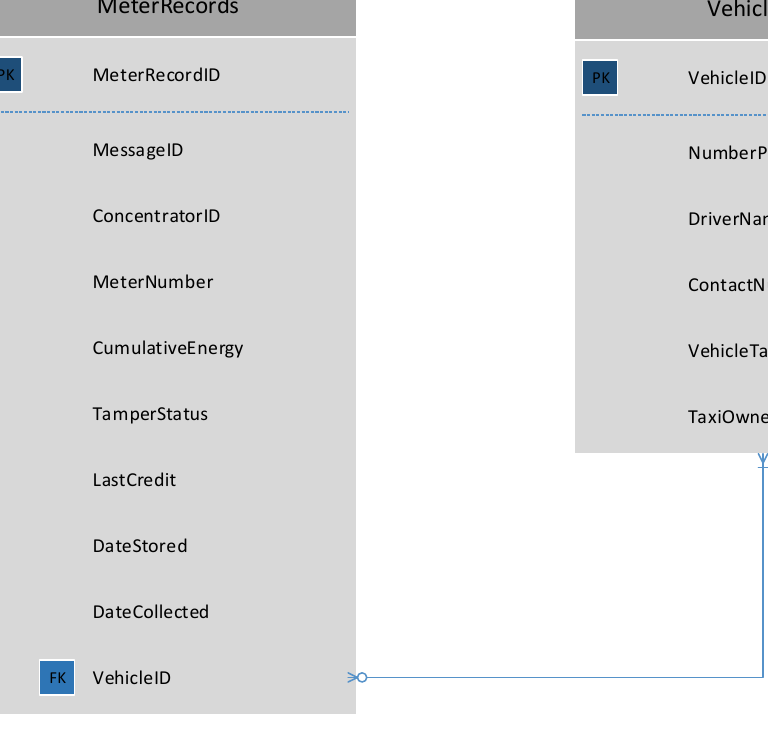
Figure 11. Data Mule Database.